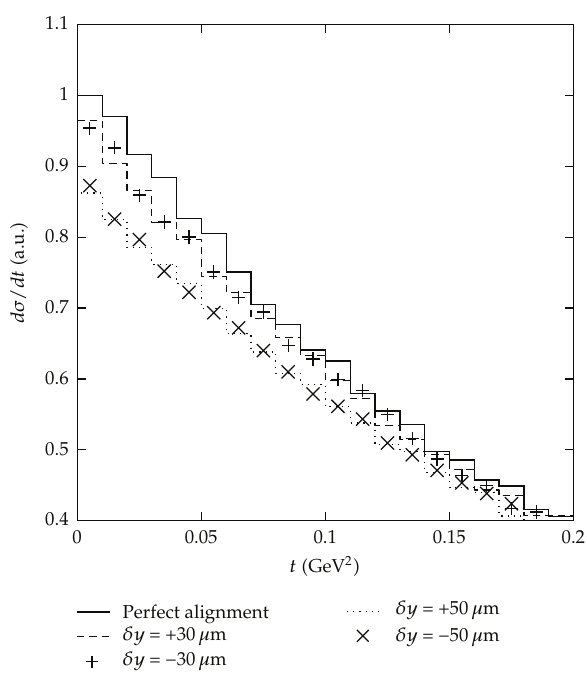
Figure 2: Reconstructed four-momentum distribution for di ff erent values of the relative vertical misalignment (cid:2) δy (cid:3)